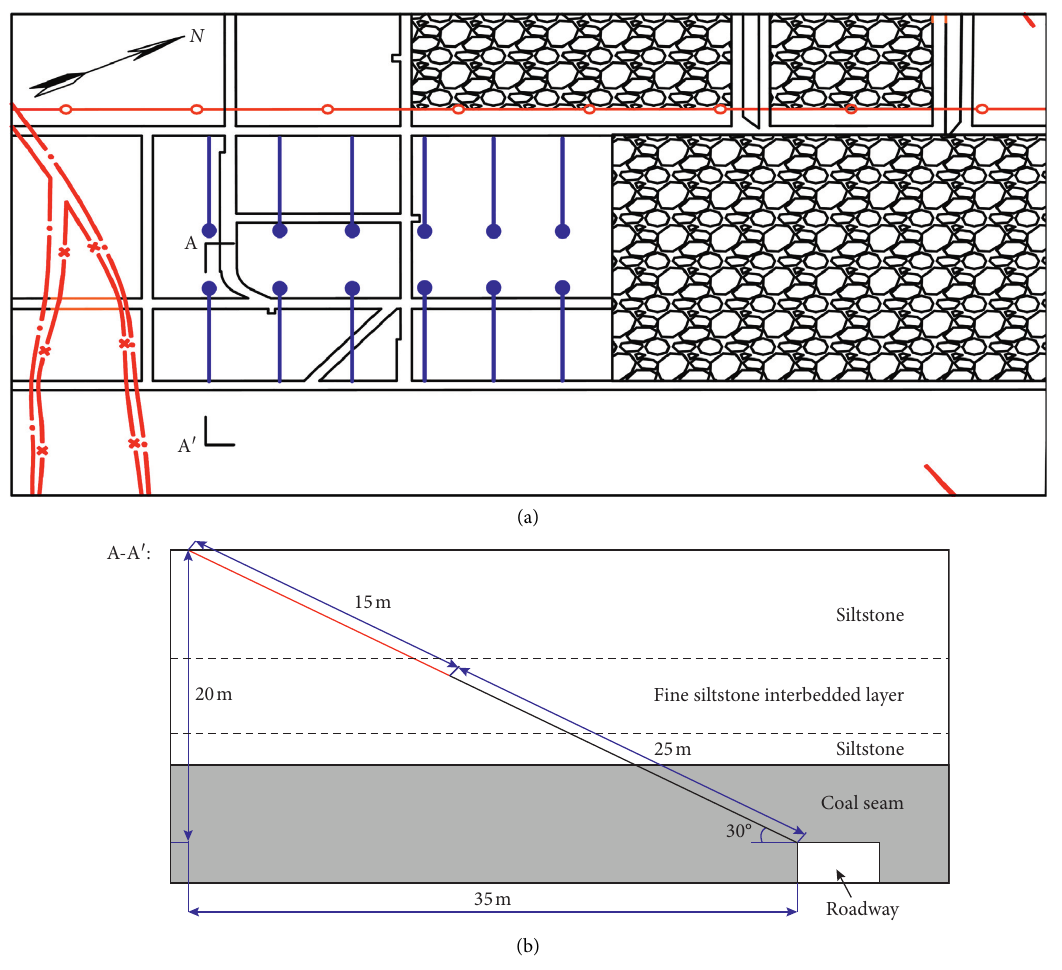
Figure 8: Layout of blasting boreholes at the roof. (a) Boreholes layout plan. (b) A-A ′ borehole profile.